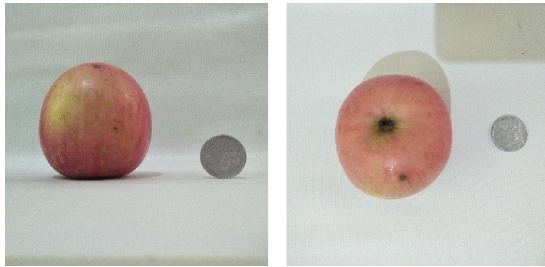
Fig. 3 The side and top view image of an apple with a 500 Rupiah coin as a calibration